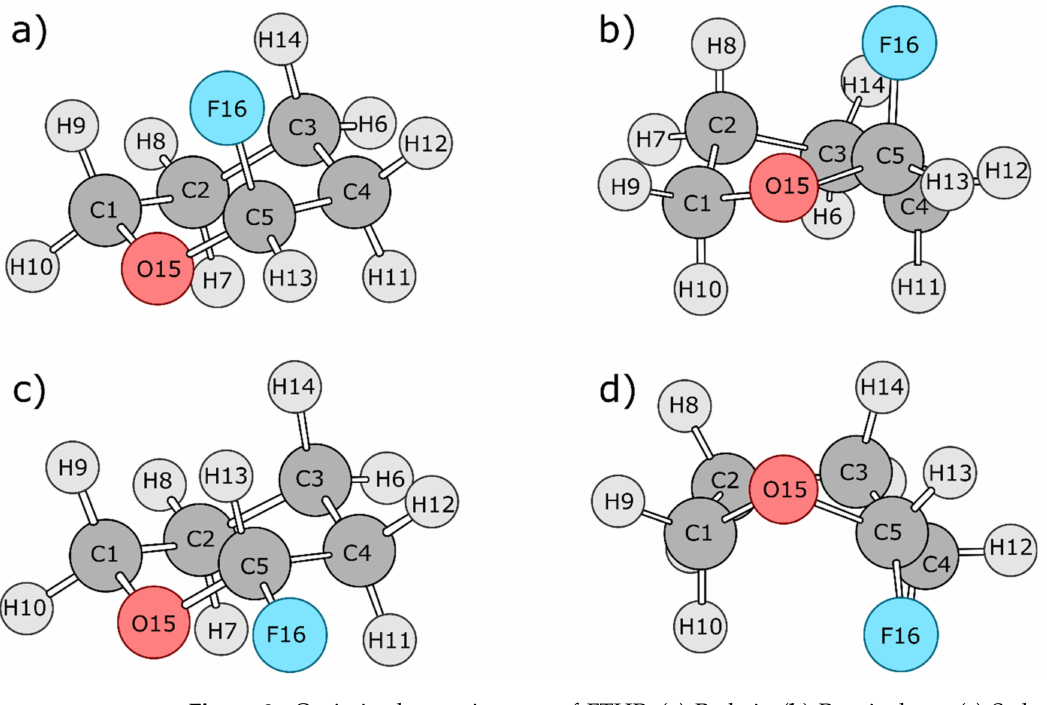
Figure 3. Optimized stereoisomers of FTHP: ( a ) R chair, ( b ) R twist-boat, ( c ) S chair, and ( d ) S twist-boat.